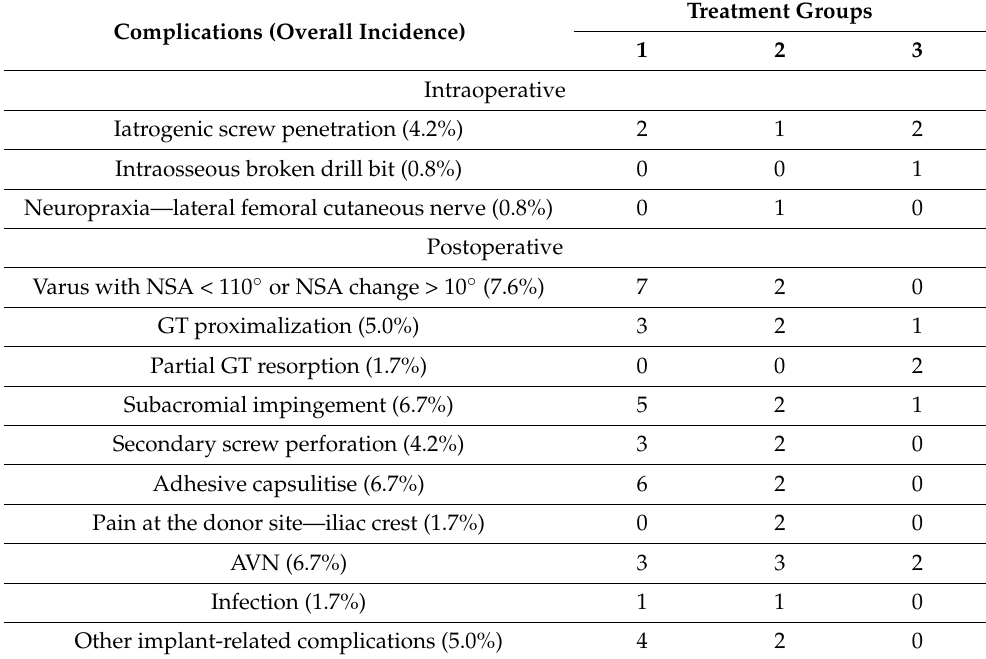
Table 6. Intraoperative and postoperative number of complication cases in treatment groups 1 (non-augmentation), 2 (bone graft augmentation) and 3 (PMMA